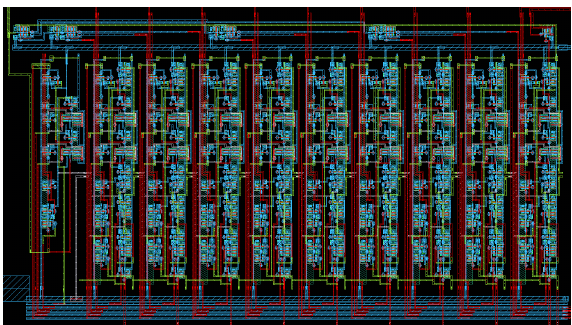
Figure 3. Layout of the proposed, programmable 10-phase clock generator, implemented in the CMOS 130 nm technology. The silicon area equals 0.0058 µ 2 , with the sizes of 105 × 55 µ